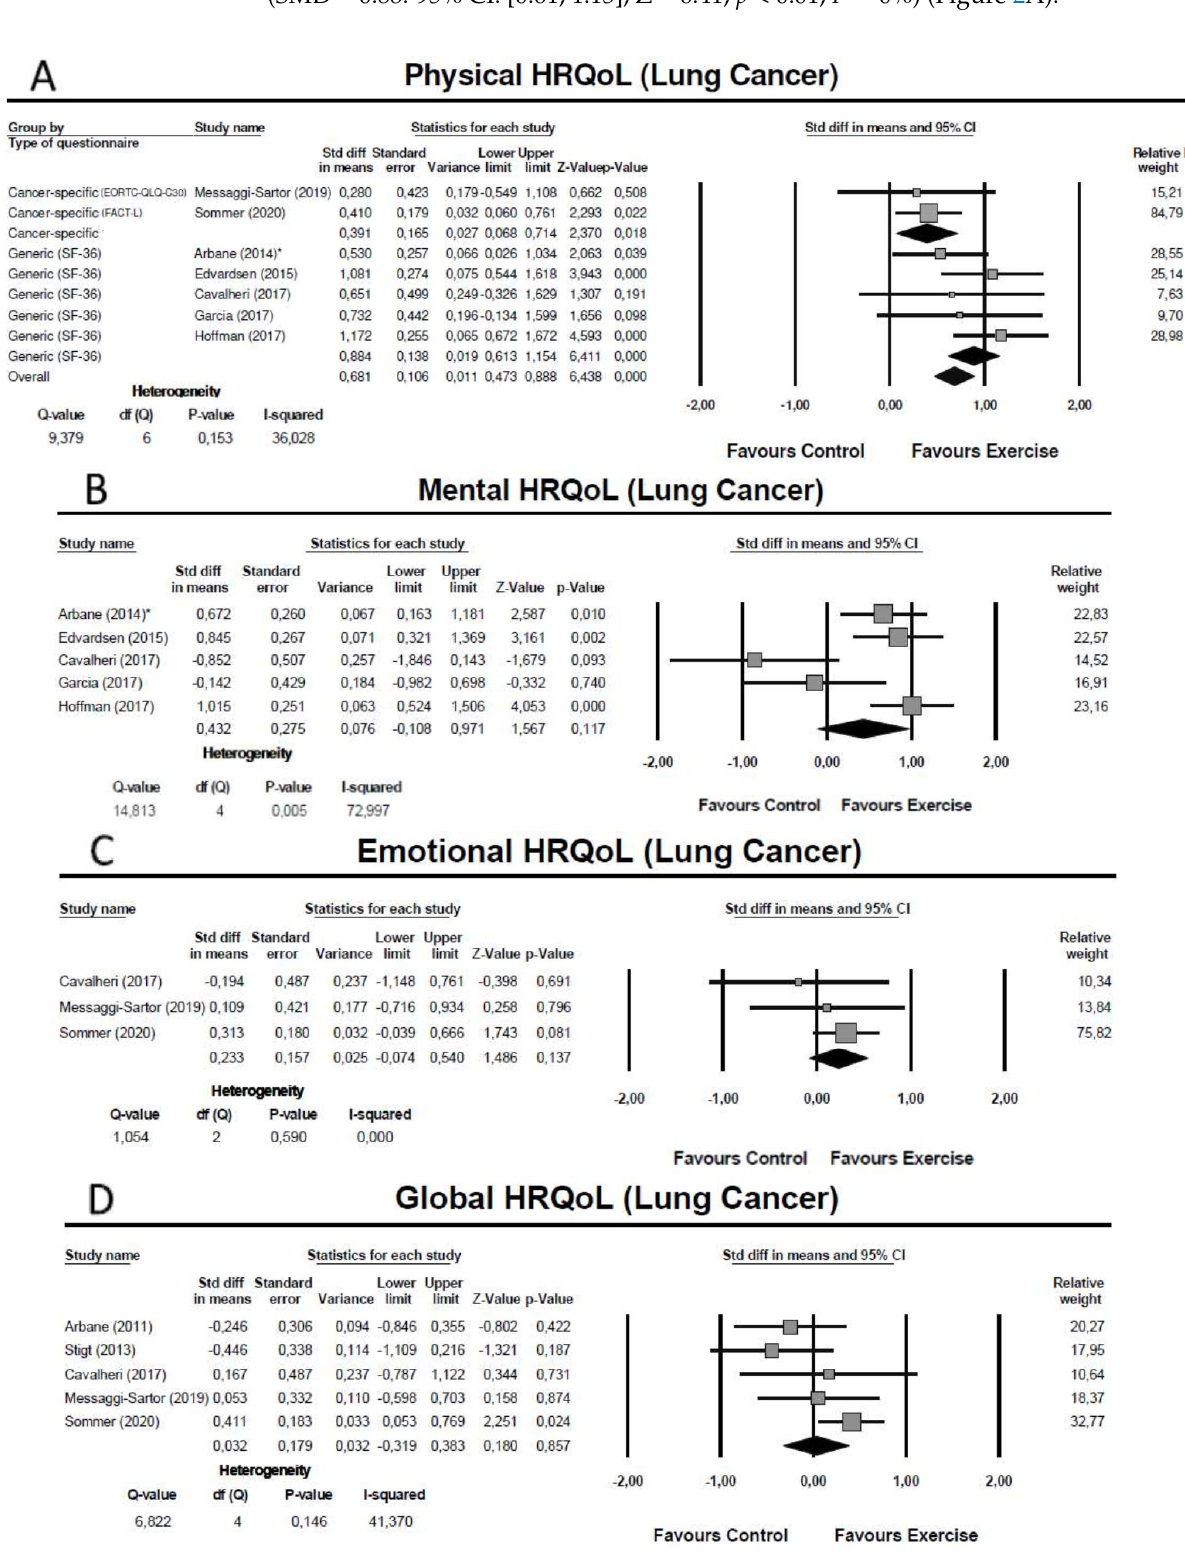
Figure 2. Meta-analysis for the effect estimate of exercise training in lung cancer patients: (A) Physical domain; (B) Mental Domain; (C) Emotional Domain; (D) Global health-related quality of life. * Subgroup of patients with airway obstruction (defined as FEV1/forced vital capacity < 0.7).